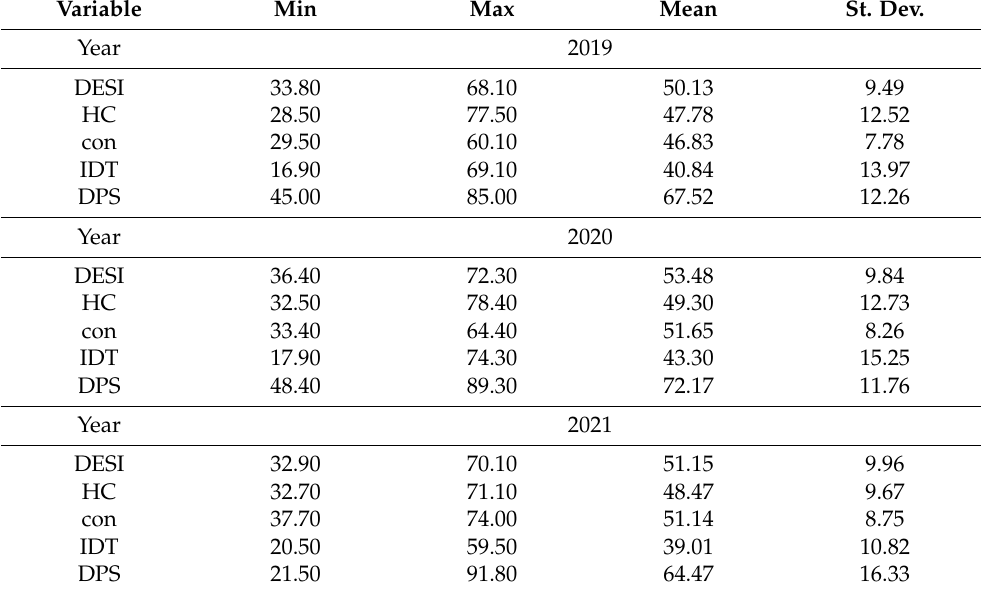
Table 2. Descriptive statistics of the DESI variables for the period